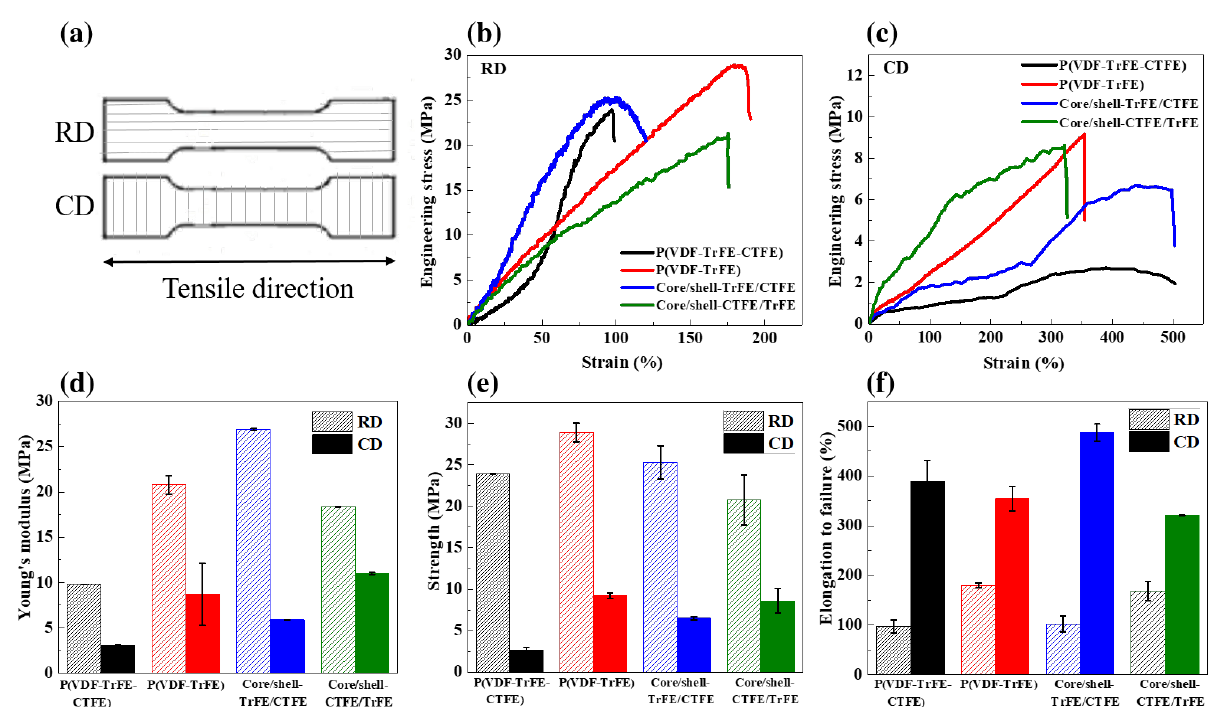
Figure 2. ( a ) Schematic illustration of tensile tests in the RD and CD. Engineering S-S curves of the four kinds of electrospun sheets in the ( b ) RD and ( c ) CD. ( d ) Young’s modulus, ( e ) tensile strength, and ( f ) elongation to failure of the single and coaxial electrospun nanofibers in both RD and CD.